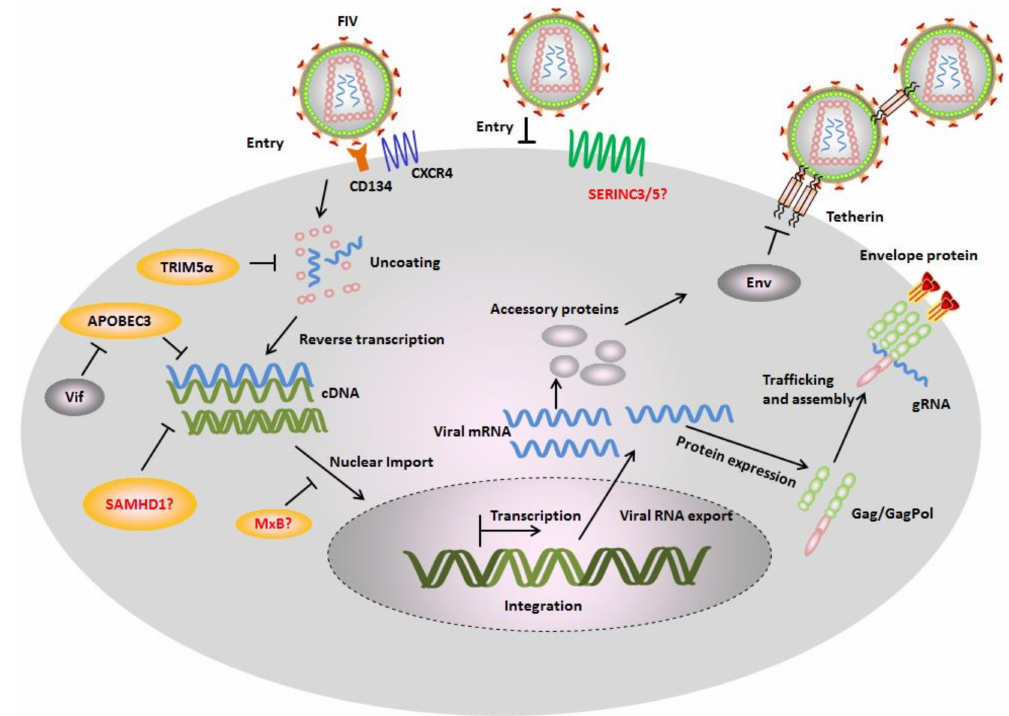
Figure 2. Feline restriction factors and FIV counteraction mechanisms. In the absence of viral antagonists, several cellular proteins called restriction factors inhibit different stages of viral replication cycle. Monkey tripartite motif-containing protein 5 α (TRIM5 α ) interacts with FIV capsid and inhibits an early infection step. Felines expresses a truncated TRIM5 gene that appears to have no antiretroviral activity, while the artificial fusion protein of feline TRIM5 with feline cyclophilin A (CYPA) displays potential inhibition against FIV. Feline apolipoprotein B mRNA-editing enzyme, catalytic polypeptide-like 3 (APOBEC3) induce hypermutations of FIV genomes by its cytidine deamination activity. It is still unknown whether feline expresses serine incorporator protein 3/5 (SERINC3/5) and whether they contain antiviral activity. Cats have mutation in the MxB genes resulting in a very short transcript not encoding a functional protein. Feline tetherin prevents FIV release from cell surface. The restriction factors are counteracted by FIV encoded proteins. FIV Vif interacts with feline APOBEC3s and induces their degradation by the proteasome pathway. FIV Env counteracts the restriction of